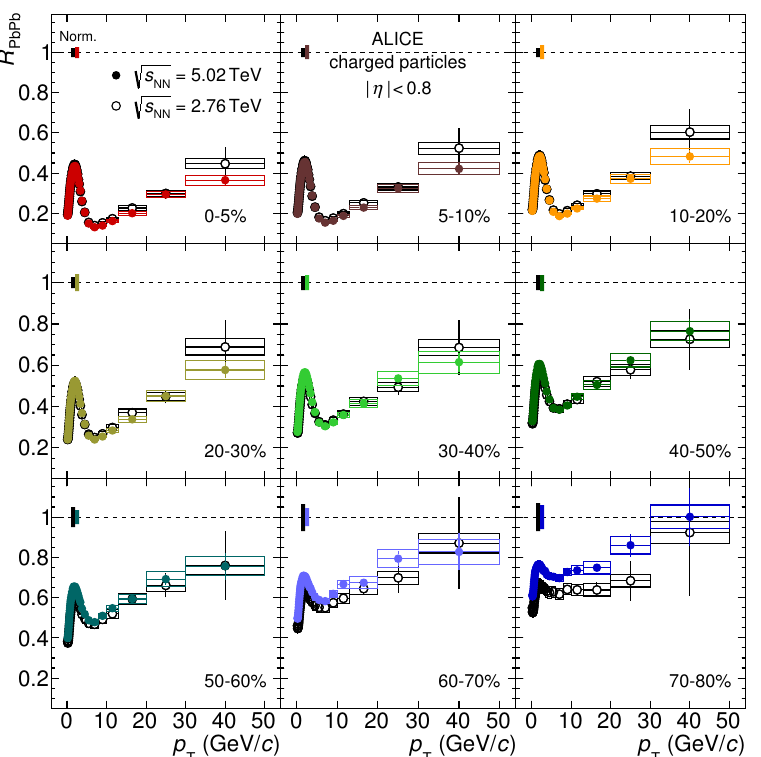
Figure 6 . The transverse momentum dependence of the nuclear modi(cid:12)cation factor measured p in Pb-Pb collisions, for nine centrality classes. The new data at s NN = 5.02 (full symbols) p are compared to the reanalyzed data at s NN = 2.76 TeV (open symbols). The normalization uncertainties are shown as boxes around unity.